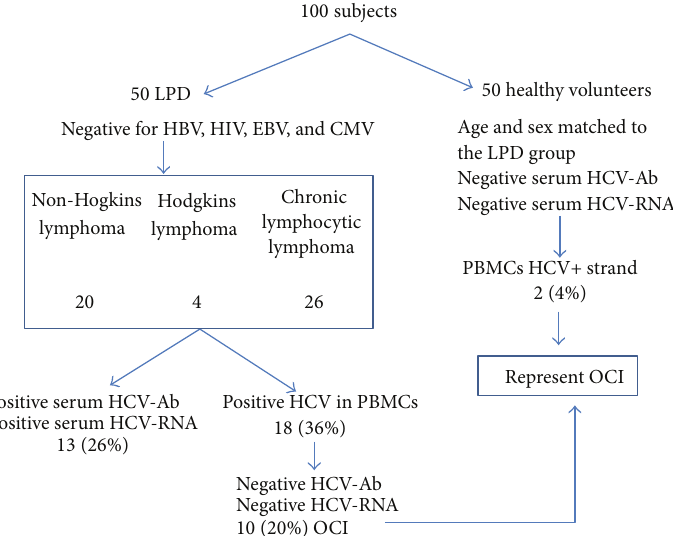
Figure 1: Prevalence of OCI in patients with chronic lymphoproliferative disorders (LPD). OCI was detected in 20% of the LPD group versus 4% in controls, adapted from [103].